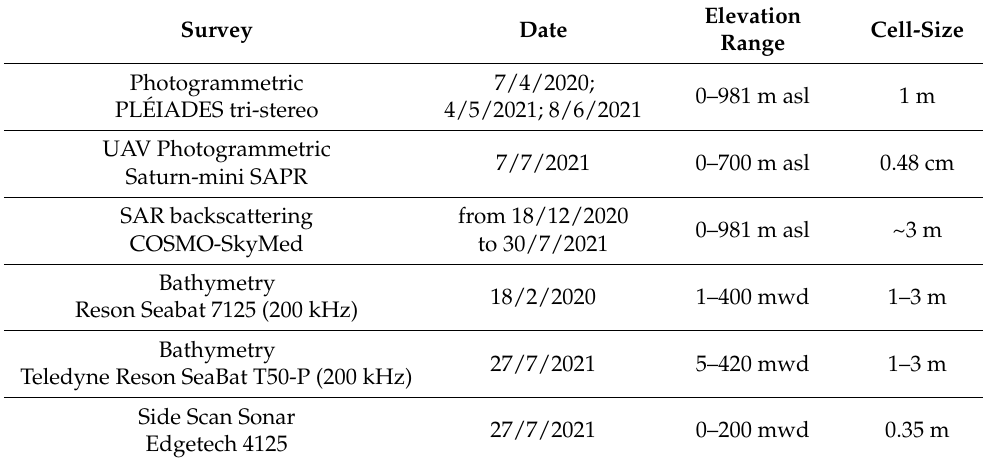
Table 2. Timetable of the topo-bathymetric surveys used for monitoring the morphological evolution of the SdF during the February 2020–July 2021 period; mwd: metre water